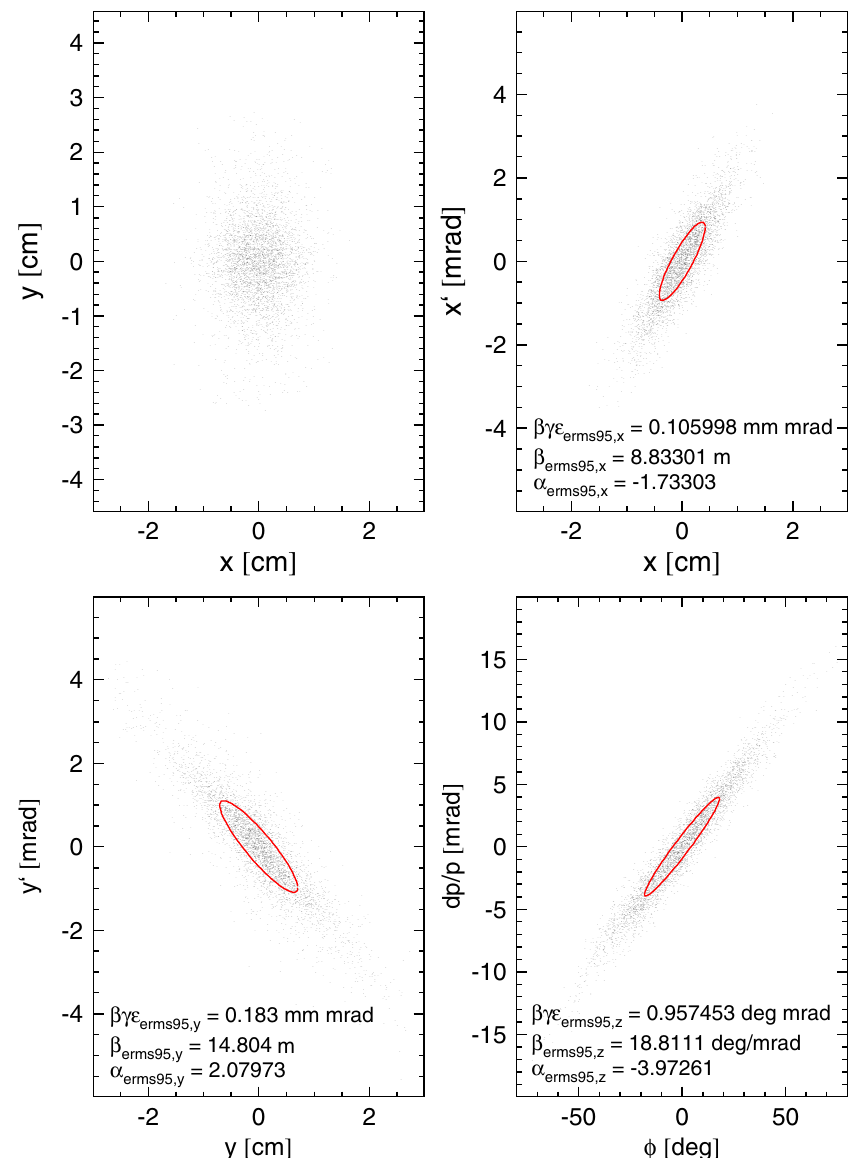
FIG. 9. (Color) Initial distribution used for the DYNAMION simulations (4300 particles). The 95%-rms-Twiss parameters from 95% of the particles are indicated. The phase refers to 36